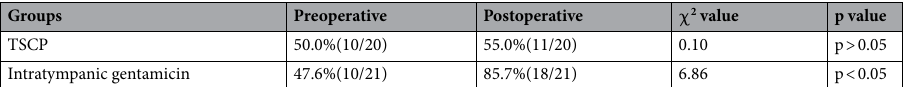
Table 5. Abnormal rate of oVEMP pre- and post-operatively in TSCP and intratympanic gentamicin patients.